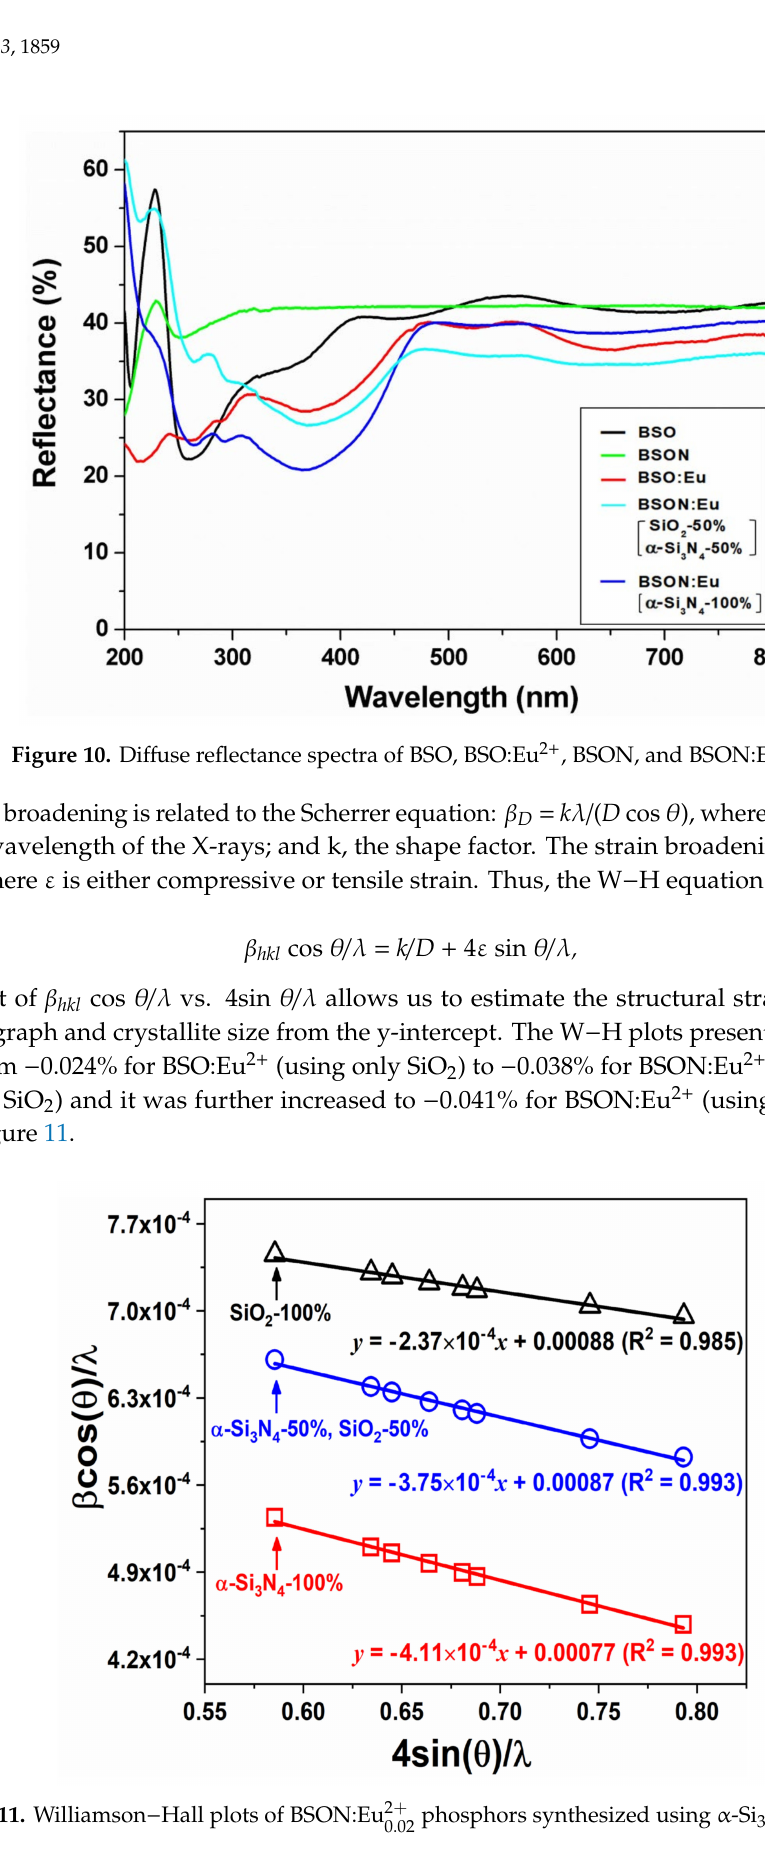
phosphors synthesized using α -Si 3 N 4 and SiO 2 0.02